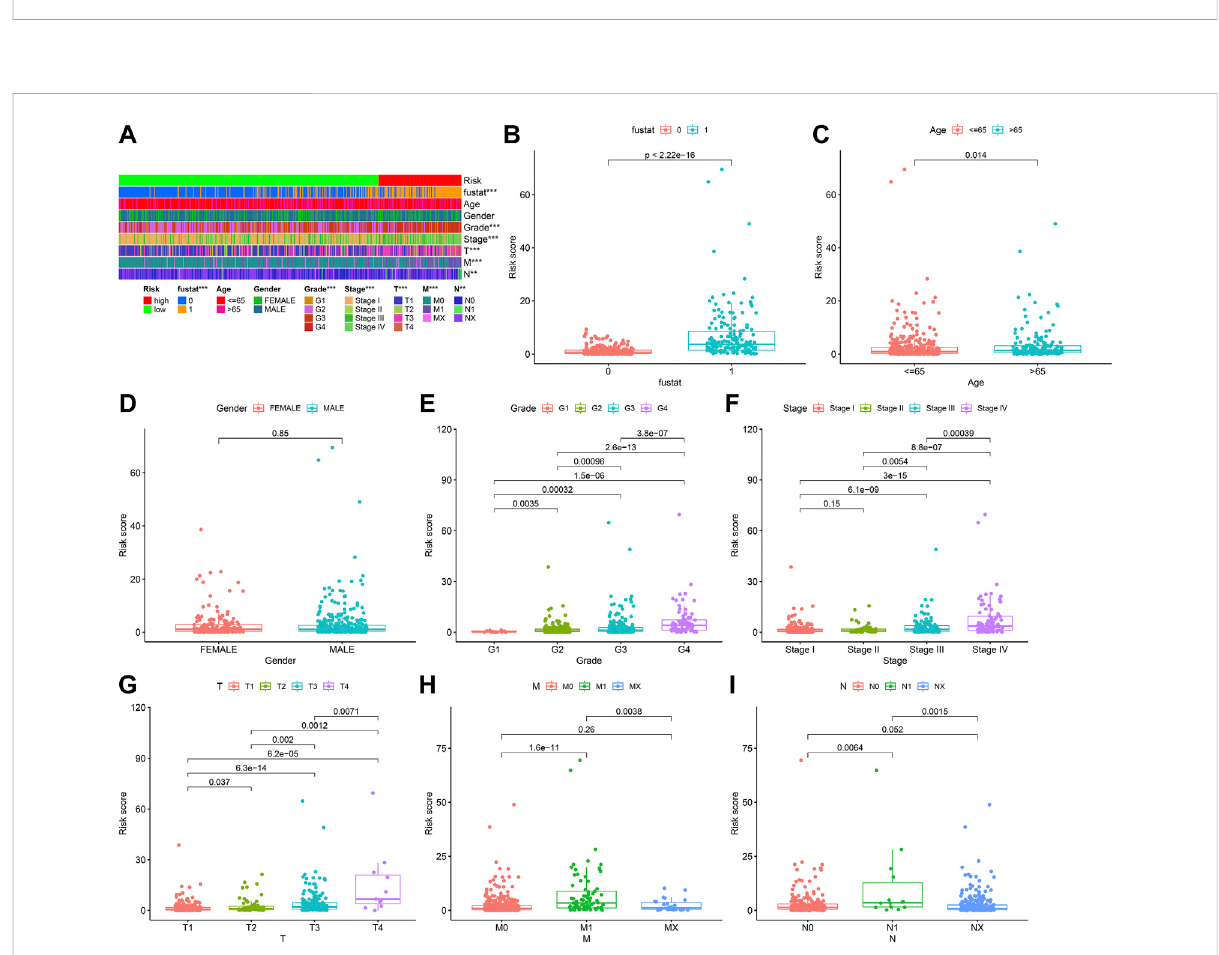
FIGURE 5 Clinical correlation of prognosis marker using clinic pathological features of ccRCC patients. (A) Bar charts summarizing common clinical features (B) Survival status ( p < 0.001). (C) Age ( p > 0.05). (D) Gender ( p > 0.05). (E) Tumor grade ( p < 0.001). (F) Clinical stage ( p < 0.001). (G) T stage ( p < 0.001). (H) M stage ( p < 0.001). (I) N stage ( p <